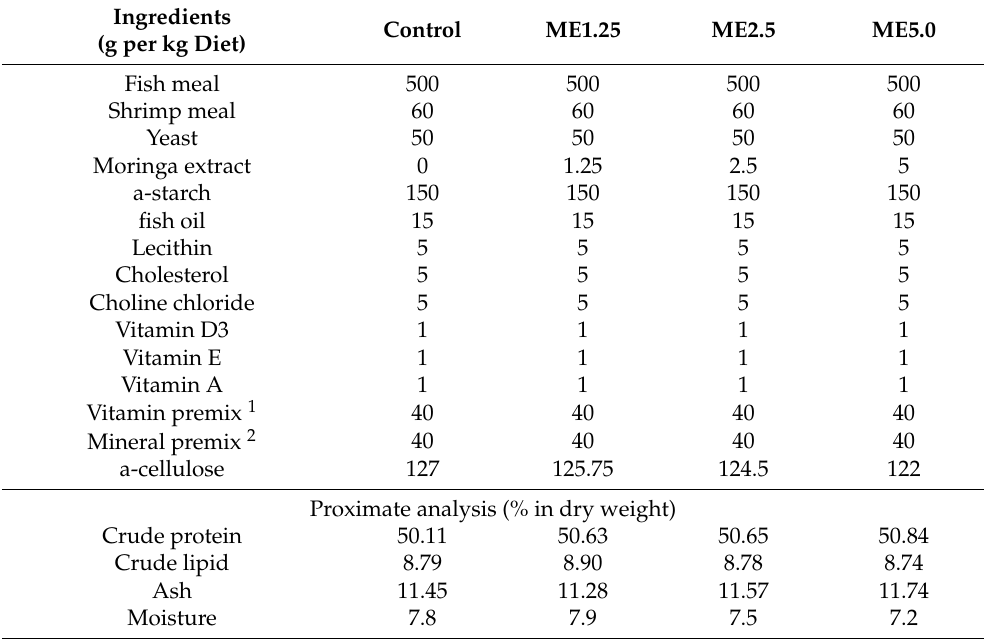
Table 1. Ingredients and proximate diet